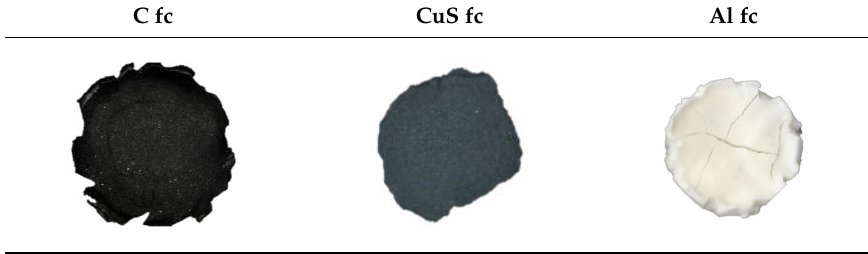
Table 11. Pictures of the obtained filter cakes apart from Li–fc (see Figure 11b) by leaching with HNO